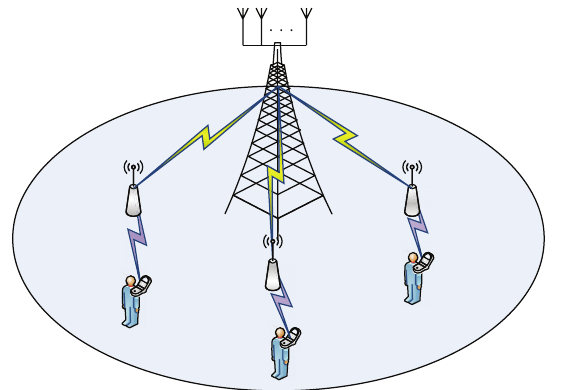
Figure 6: Multiuser communication through multiple relays. Figure 7: (Left) Two-way single pair communication, (right) two- way multi-pair